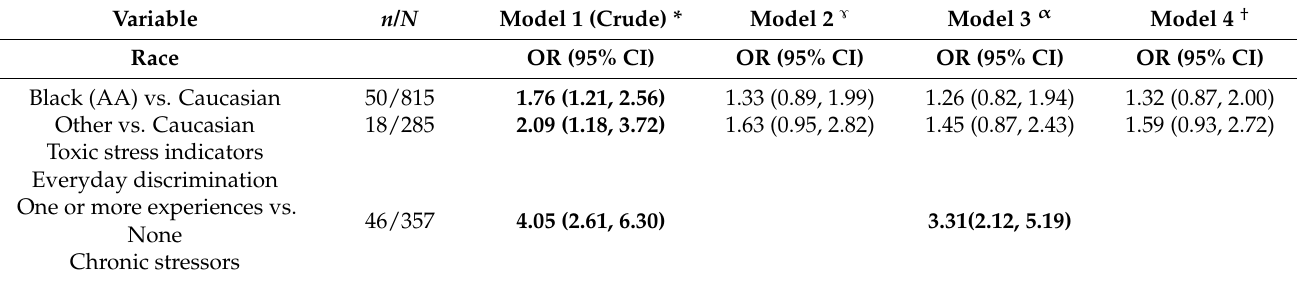
Table 3. Race, Toxic Stress, and Resilience promoting factors in relation to risk for Neurocognitive impairment among older American adults enrolled in the HRS